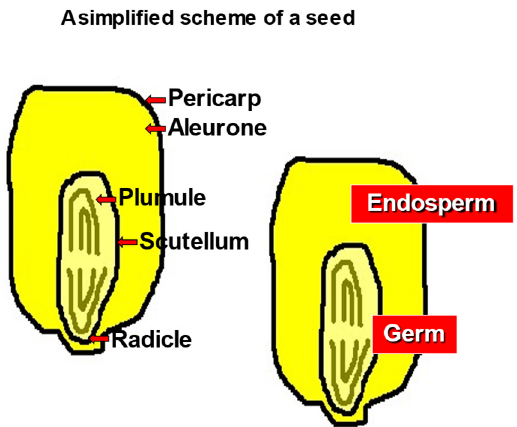
Figure 1. Simplyfied scheme of a seed.